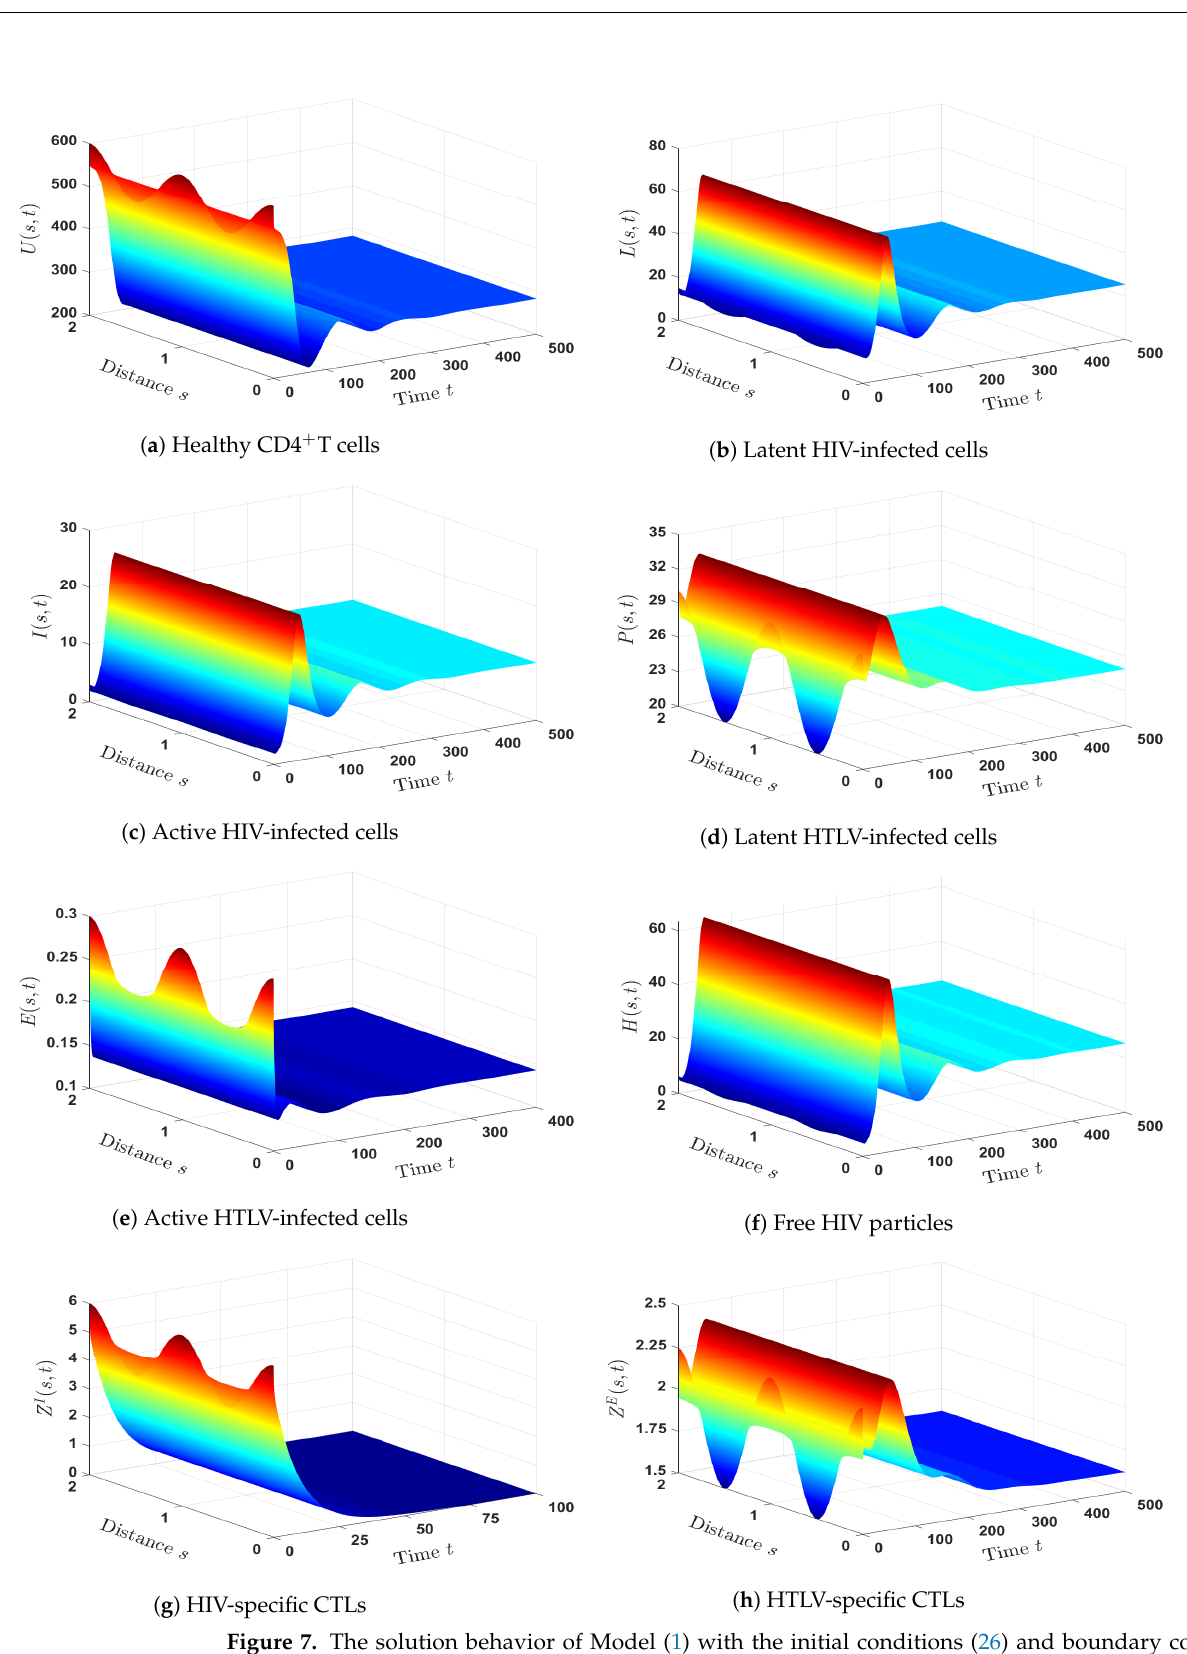
Figure 7. The solution behavior of Model (1) with the initial conditions (26) and boundary con- ditions (27). Taking ω 1 = 0.0006, ω 2 = 0.0001, ω 3 = 0.0002, ω 4 = 0.04, υ 1 = 0.001, υ 2 = 0.7, we have R 6 = 2.26 > 1, R 7 = 0.17 < 1, R 2 / R 1 = 2.63 > 1, and the equilibrium ˇ S 6 = ( 282.05,25.31,10.12,24.87,0.143,25.31,0,1.62 ) is asymptotically